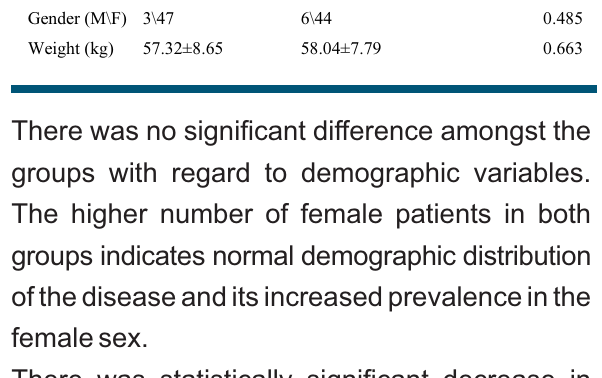
Table 5: Diastolic blood pressure (DBP) Time